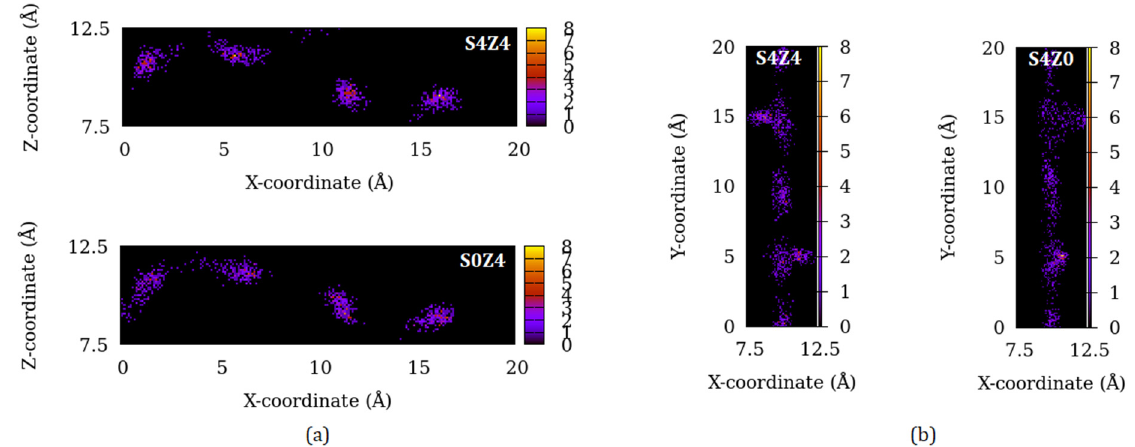
Figure 10. Distribution of the center of mass of ethane molecules adsorbed in ( a ) zigzag and ( b ) straight channels of unmodified silicalite (S4Z4) and silicalite with all straight (S0Z4) and zigzag (S4Z0) channels blocked. The intensity corresponds to the number of fluid molecules found at a location in 200 configurations of the system.